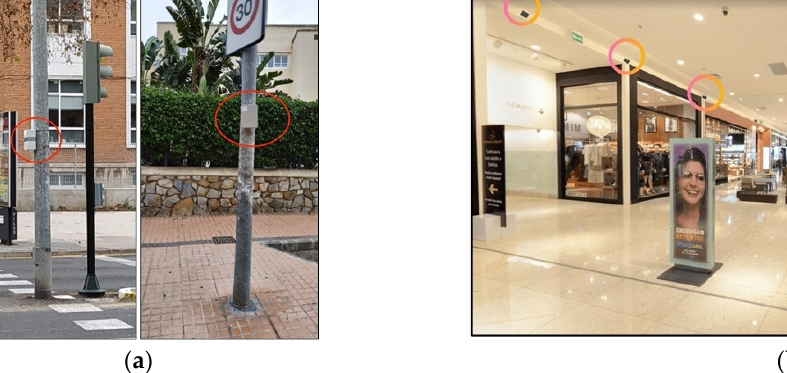
Figure 4. Example of pedestrian flows from the data obtained in the outdoor experimental tests. The image shows the number of pedestrians that moved from location x to location y in periods of time equal to 15 min. Note that the number indicates the street crossroads from crossroads 0 on the right to crossroads 7 on the left, as shown in the map above, and the sub-index at each crossroad desig- nates the street; for instance, 7.2 means street 2 in crossroad 7. Table 2. Features of the cloud server used in the real deployment. Type